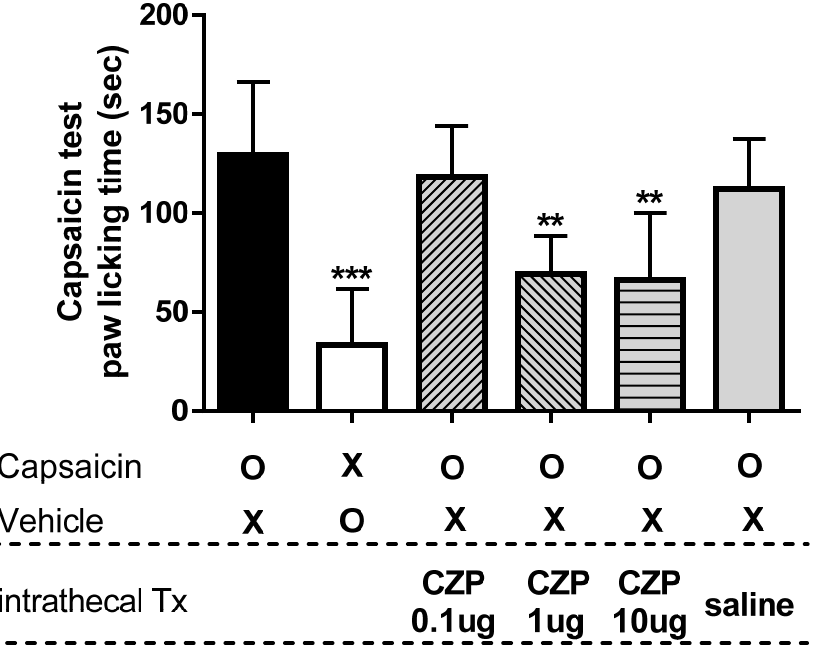
Figure 2. The graph shows the paw-licking time after intrathecal capsazepine administration in a mouse model of capsaicin-induced spontaneous pain. Intraplantar injection of capsaicin